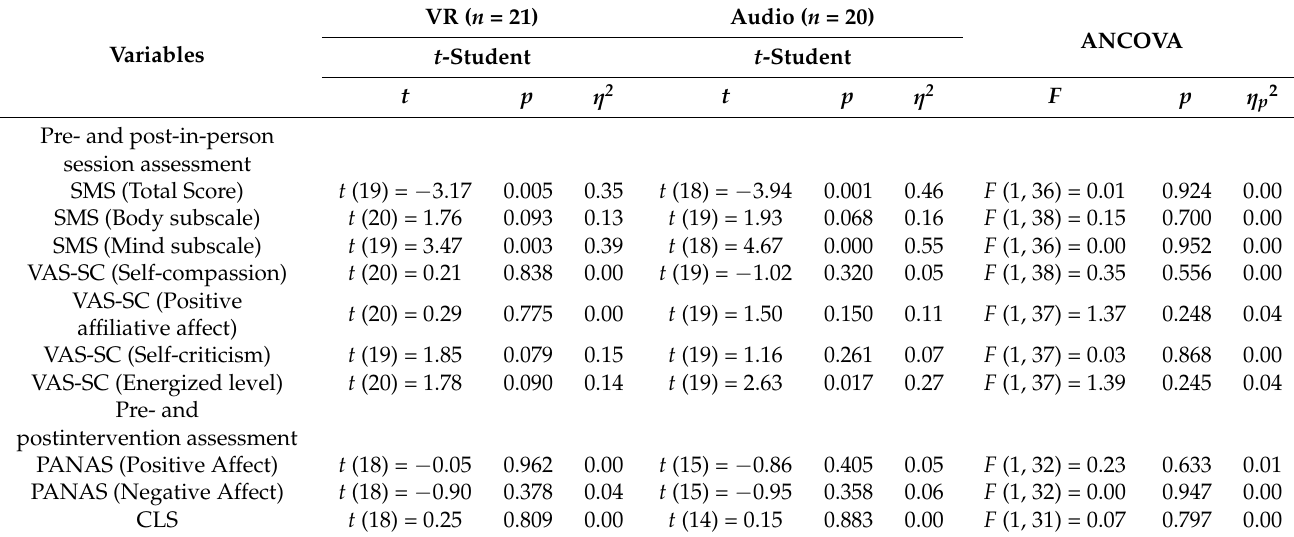
Table 3. Paired-samples t -tests and analyses of covariance (ANCOVAs) results for PANAS, CLS, SMS, and VAS-SC scores.